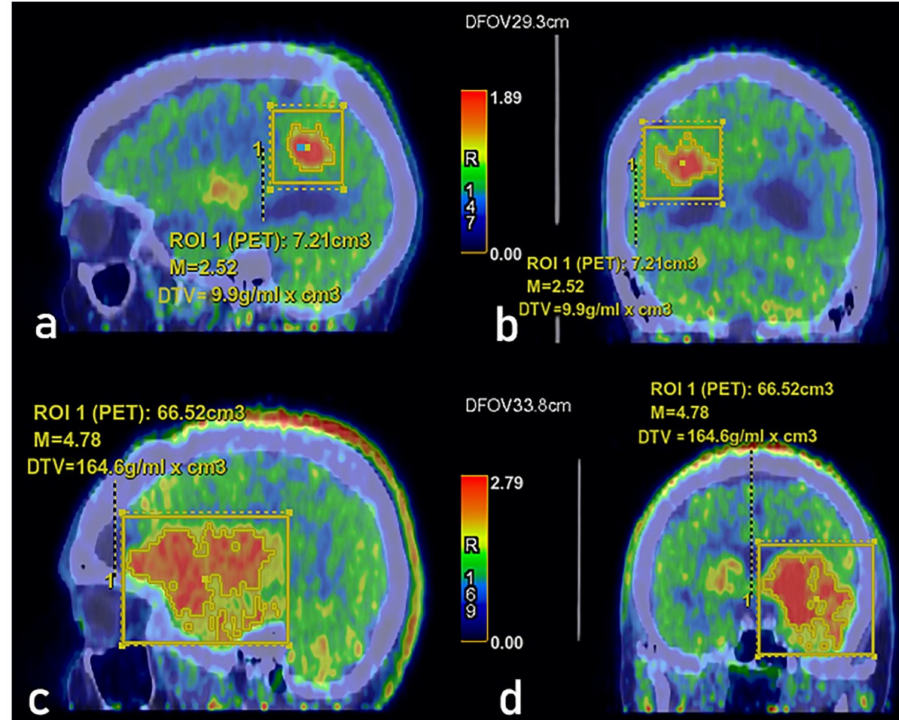
Figure 1. Dopaminergic tumor volume (indicated as DTV in the figure) calculation on a dedicated workstation (version 4.4, Advantage Workstation, GE Healthcare, Chicago, IL, USA) in a patient with Grade II glioma in sagittal ( a ) and coronal ( b ) views, and in a patient with Grade IV glioblastoma in sagittal ( c ) and coronal ( d ) views. The values of DTV are correlated to SUV max (see the